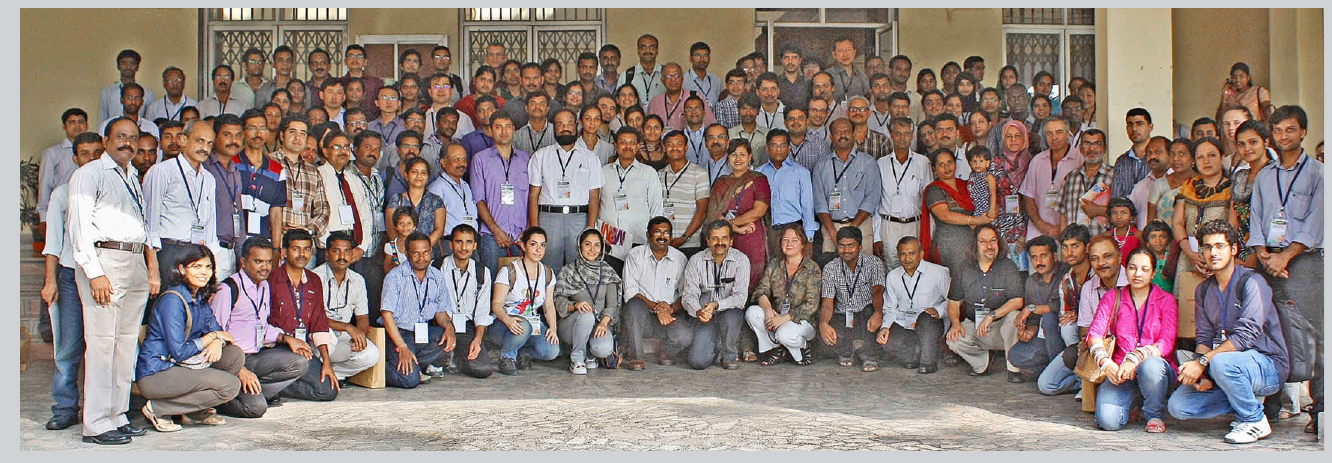
recent advances, challenges in rheology and pro- cessing of natural polymers. Push kala R. (Sri